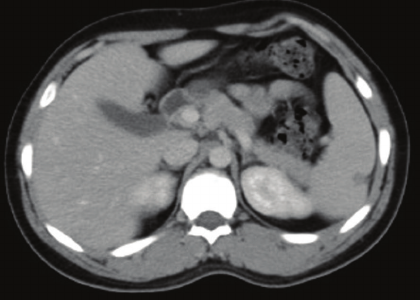
Figure 2: Repeated CT abdomen showing marked regression of the largest lesion while disappearance of